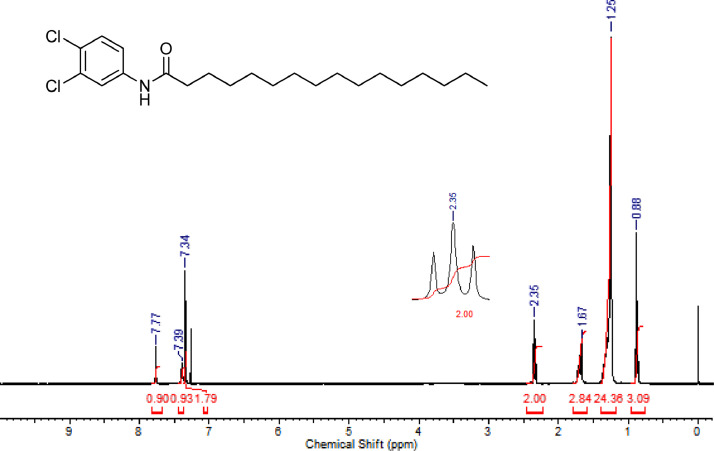
1H NMR (CDCl3, 400 MHz) spectrum of compound 11a.